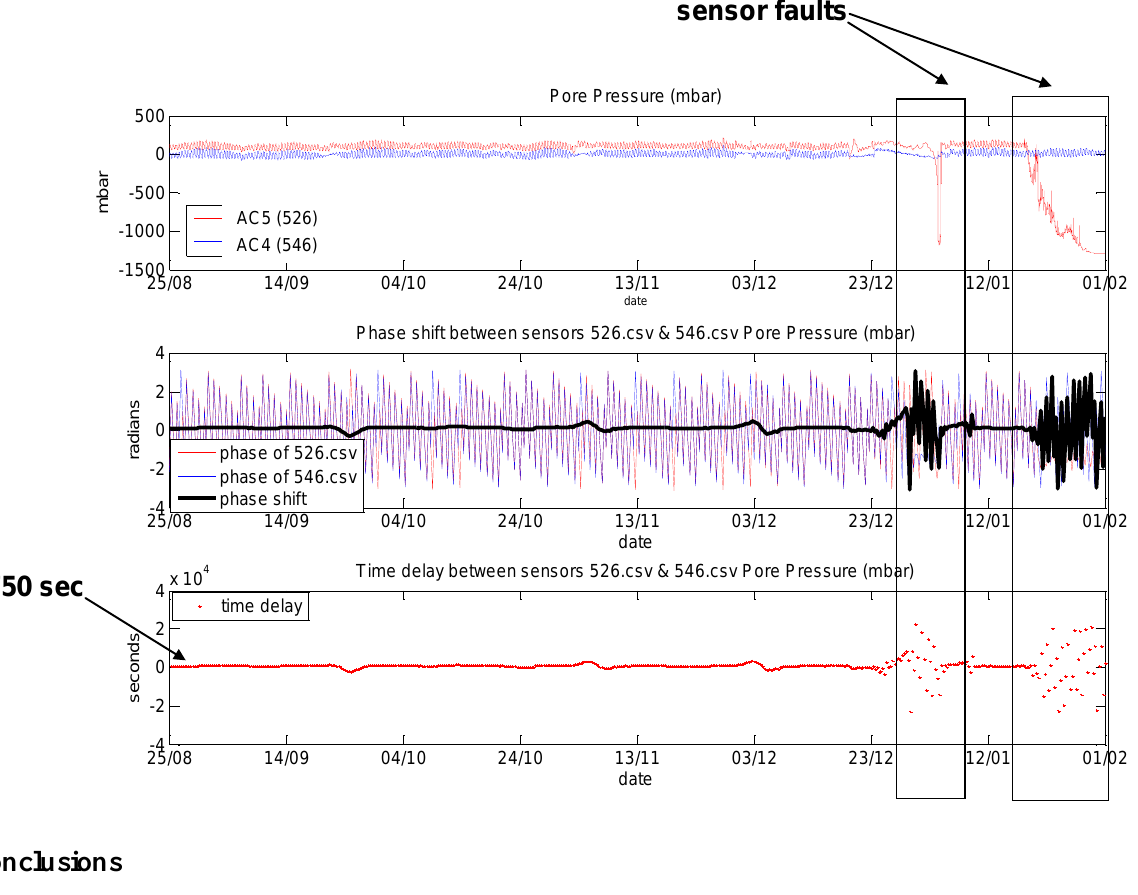
Figure 25. Application of the phase delay method to pore pressure sensors analysis: AC5 (id 526) with periods of abnormal behaviour and ―normal‖ AC4 (id 546) from Boston dike (UK). Phase delay was calculated for one of the base frequencies—12 h, width of window for STFT calculation—512 samples, rate of measurements—15